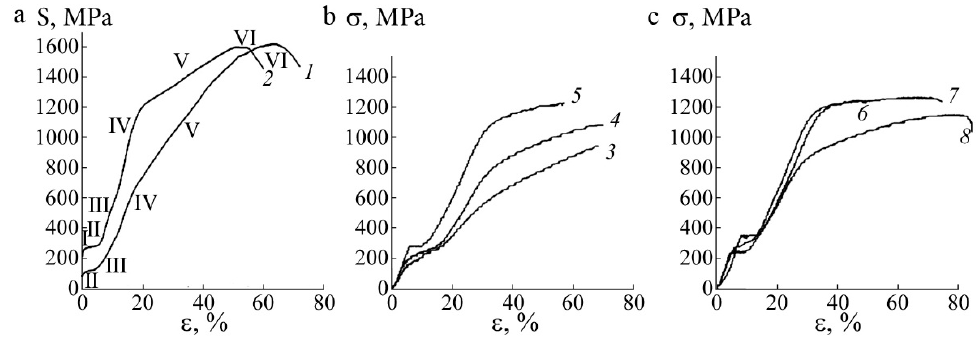
Figure 7. ( a ) “True stress–strain” and ( b , c ) “resolved stress–strain” curves after tensile tests at RT of ( a ) the (1) CG and the (2) UFG ECAP-treated Ti 49.4 Ni 50.6 alloy, ( b ) (3) the CG Ti 49.5 Ni 50.5 alloy and the (4, 5) UFG Ti 49.5 Ni 50.5 alloys preliminary subjected to ECAP at 723 K, for (curve 4) 1 pass and (curve 5) 4 passes, and ( c ) the UFG Ti 49.5 Ni 50.5 alloy after (6) ECAP at 723 K, 8 passes and + (7) the subsequent PDHT at 773 K, 1 h, or + (8) the subsequent PDHT at 873 K, 1 h [65,73]. As can be seen, regardless of the grain size in the Ti 49.4 Ni 50.6 alloy, almost identical qualitative changes in mechanical properties and the type of tensile «stress–strain» curves S( ε ) are observed during the transition from the usual CG to the UFG grain structure. Until